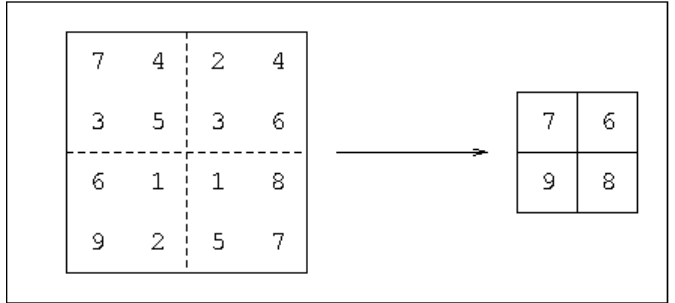
Figure 2. The max-pooling operator applied to a 4 × 4 matrix with four non-overlapping regions of size 2 ×